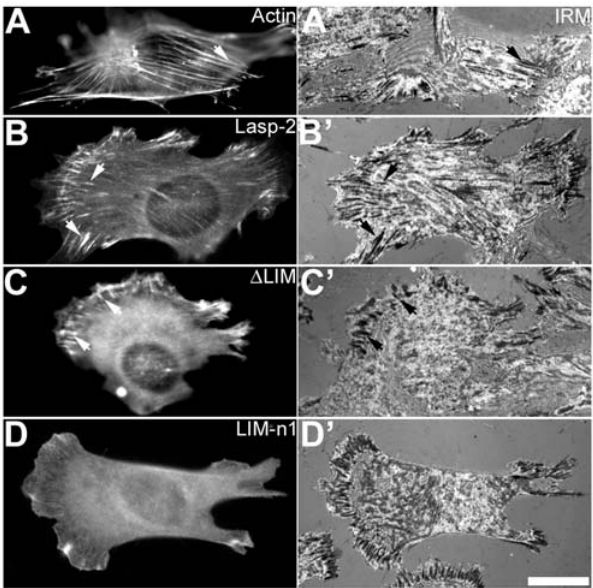
Figure 4. Localization of EGFP-tagged lasp-2 fragments in C2C12 cells. Cells transfected with EGFP-actin (A), EGFP-lasp-2 (B), EGFP- D LIM (C), or EGFP-LIM-n1 (D) are shown as indicated. Corre- sponding images of interference refraction microscopy (IRM) are shown as A 9 to D 9 . The block arrows indicate the position of focal contacts visualized by IRM, and the corresponding areas in the fluorescence images are indicated by white arrows. The bar in D 9 represents 10 m m. doi:10.1371/journal.pone.0007530.g004 an N-terminal fragment of lasp-1 composed of the LIM domain and a tandem twin nebulin-repeat [25]. In addition, various nebulin fragments containing plural nebulin-repeats from the